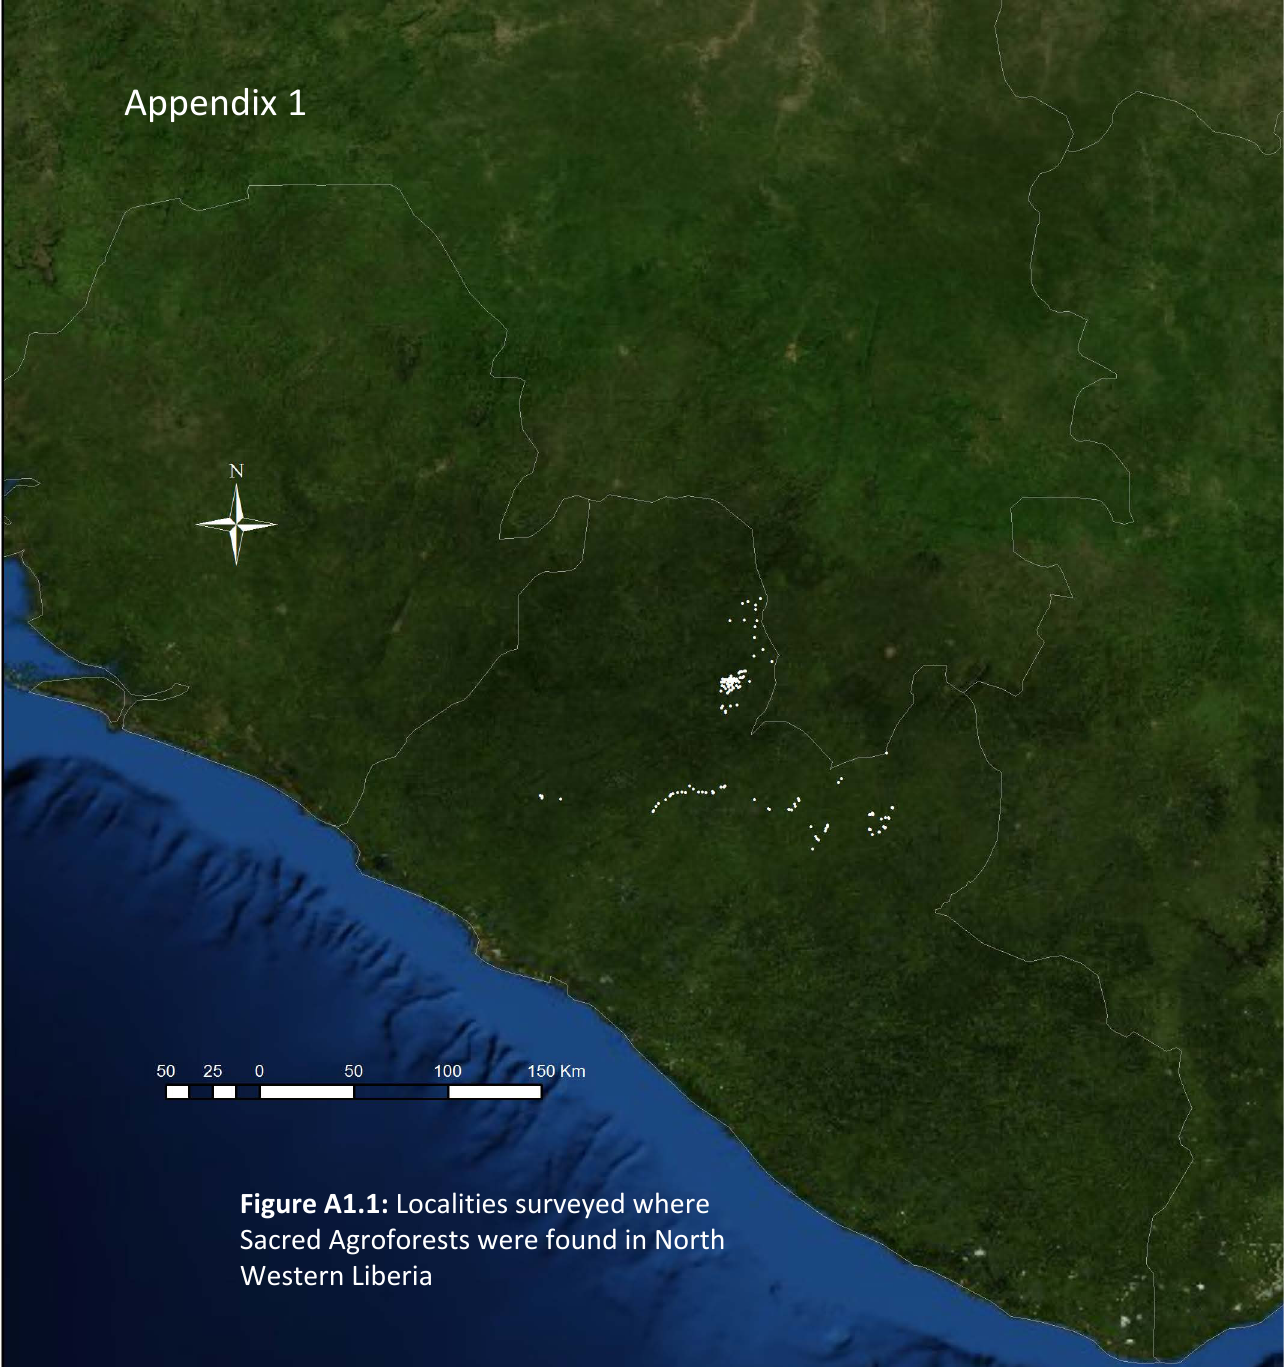
Figure A1 .1 : Localities surveyed where Sacred Agroforests were found in North Western